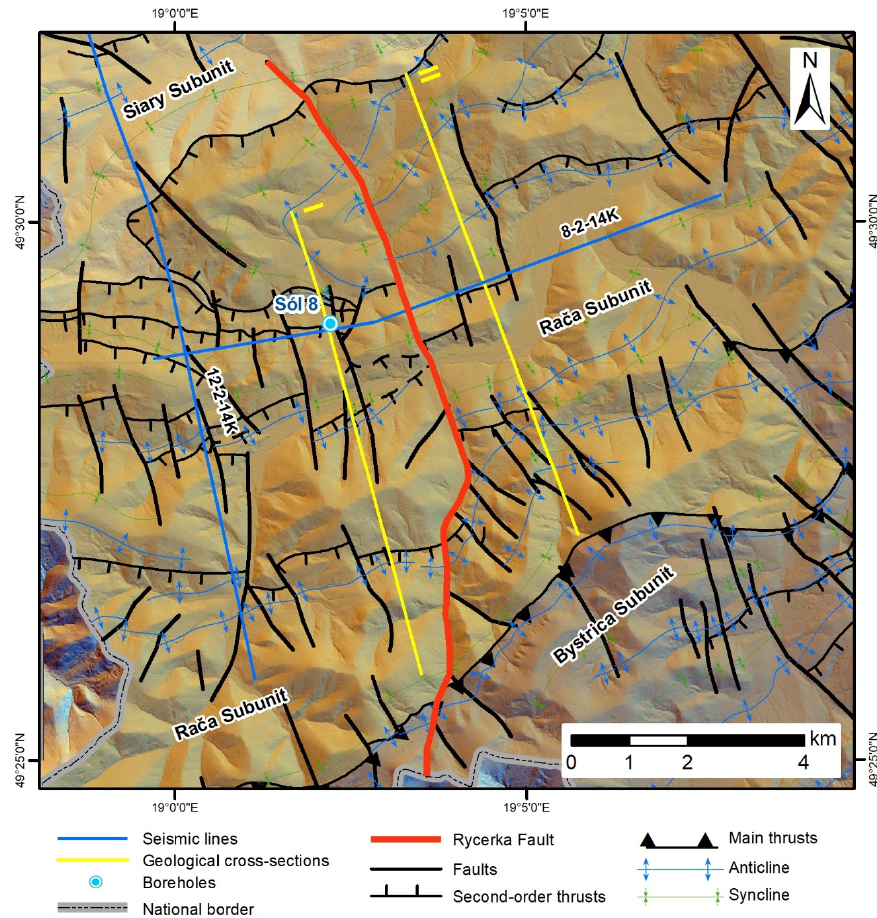
Figure 7. Structural maps of the investigated area displayed on top of the DEM.